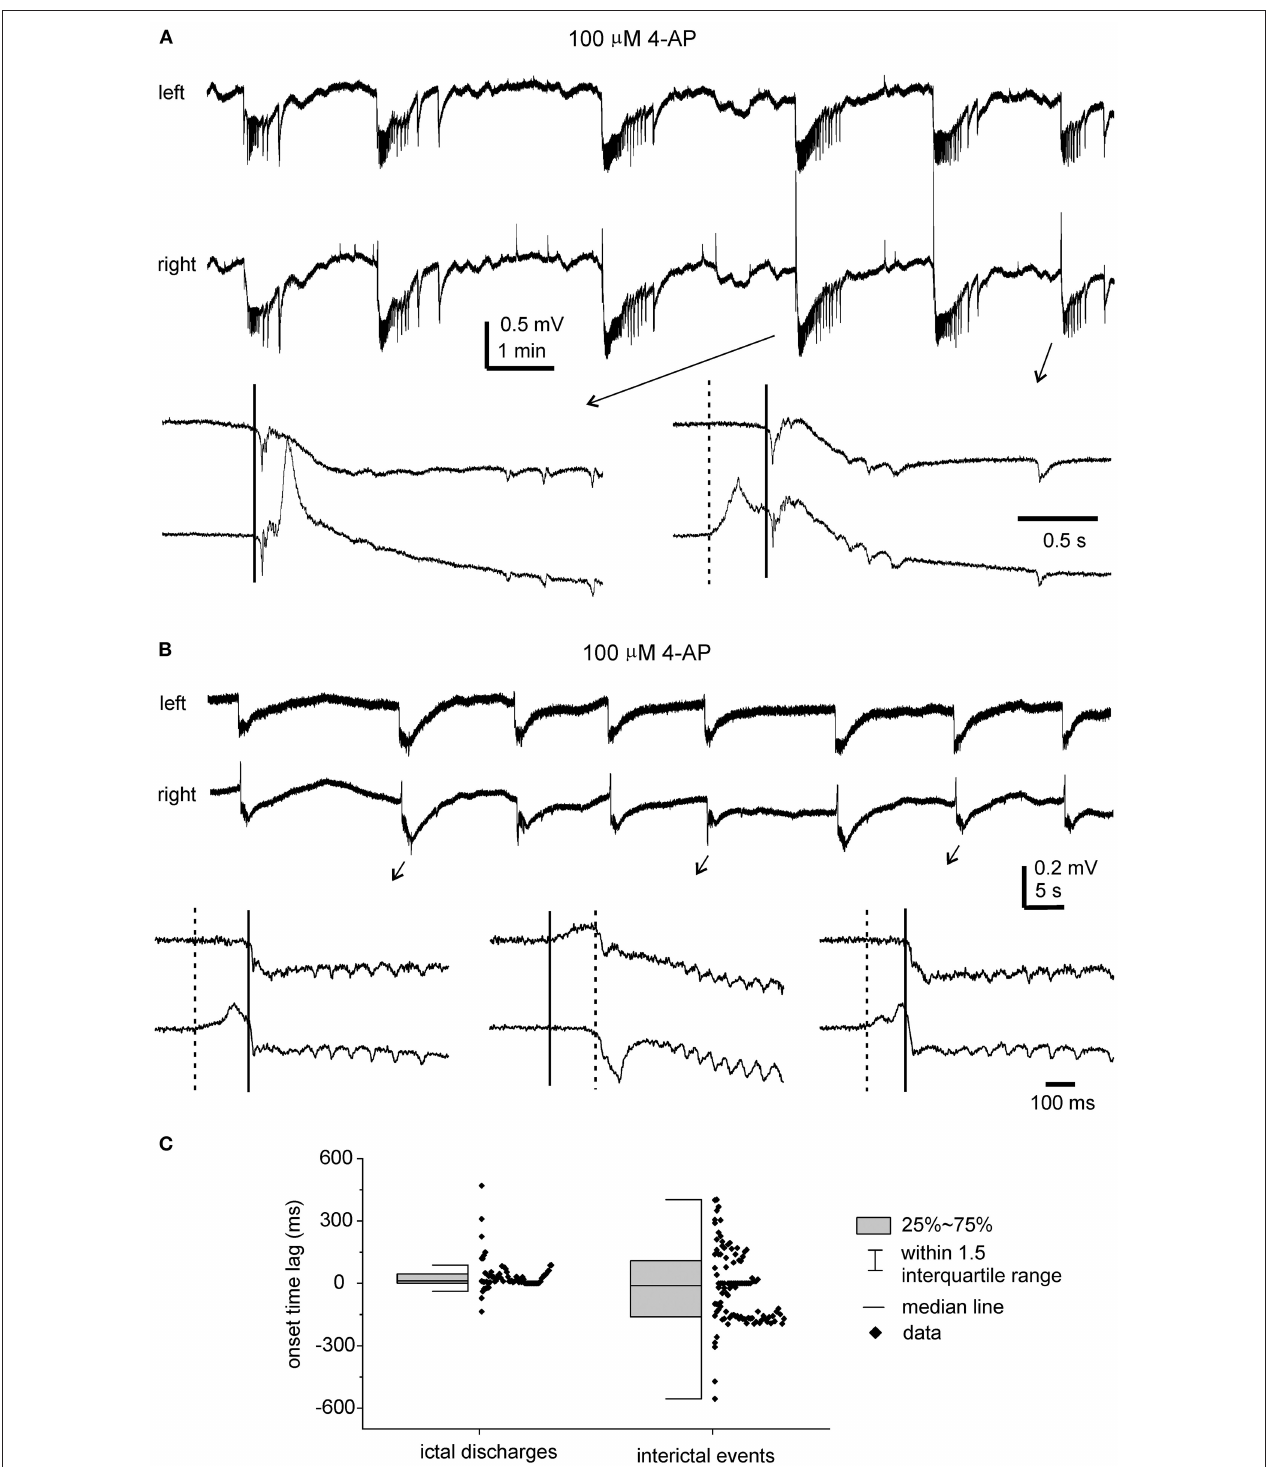
FIGURE 4 | 4-AP induced, bilaterally correlated epileptiform field potentials. Bilateral hippocampal slices were obtained from 2 mice (22- or 24-days-old). Epileptiform field potentials were induced by 100 µ M 4-AP. (A) Recurrent ictal-like discharges illustrated after treatment with a low-pass filter (500Hz, Bessel, 8-pole). Arrowed events were expanded to show initial parts of corresponding bilateral discharges. Solid and dotted lines denote putative onset times of right and left hippocampal discharges. (B) Intermittent interictal-like events were illustrated after treatment with a low-pass (200Hz) filter. Arrowed events were expanded below and similarly illustrated as in (A) . (C) Measured onset time lags of bilaterally correlated ictal discharges (37 events from 5 slices) and interictal events (108 events from other 5 slices).